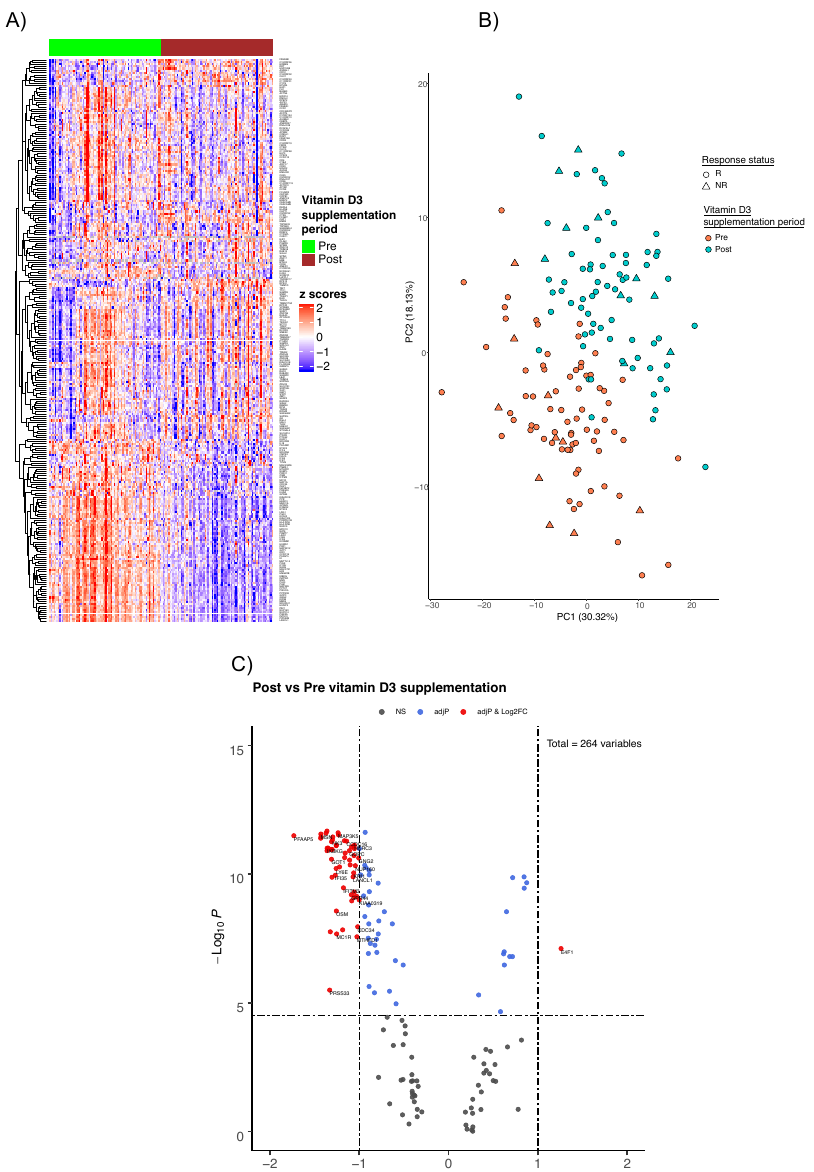
Figure 5. Gene expression profile and differential analysis pre and post vitamin D3 supplementation. ( A ) Heatmap representation of normalized gene expression profiles ordered by supplementation phases/periods (i.e., pre and post vitamin D3 supplementation periods). The rows represent the tar- geted gene panel (264 genes) and the columns represent the pre and post vitamin D3 supplementation periods of the 80 study participants (total 160 columns). ( B ) Principal component analysis overlapped with the participants’ response to vitamin D supplementation (see METHODS for details). Supple- mentation periods are depicted by color and the response status by shape as described in the legend. ( C ) Volcano plot representation of the differentially expressed genes between supplementation peri- ods; Log 2 fold-change and -Log 10 p -value are expressed on the x- and y-axis, respectively. Genes that are non-significantly expressed (NS) are depicted as black dots. Blue dots correspond to genes that have a Log 2 fold-change between − 1 and 1, but with significant p -values. Red dots correspond to genes that have a fold-change smaller than − 1 or greater than 1 and significant p -values. Statistical comparison of gene expression between pre and post periods was performed using Wilcoxon Signed Rank Test with Bonferroni correction. Significance was assigned if adjusted p -value < 3 × 10 − 5 and is indicated by the horizontal dashed black line. The vertical dashed black line indicates a Log 2 FC of 1 in gene